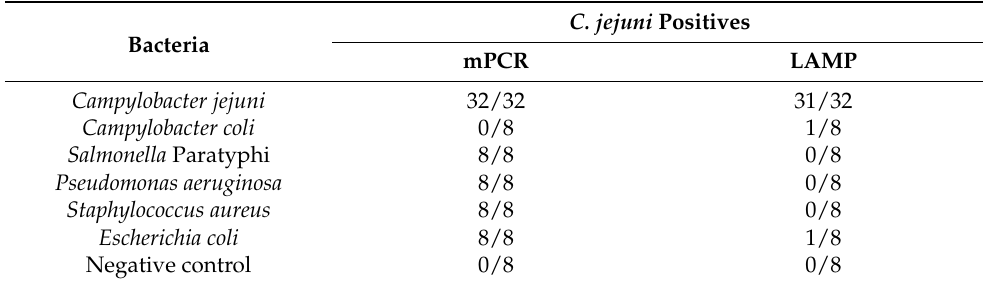
Table 6. Specificity test of LAMP and multiplex PCR (mPCR) assays for detection of C. jejuni and other foodborne bacteria.